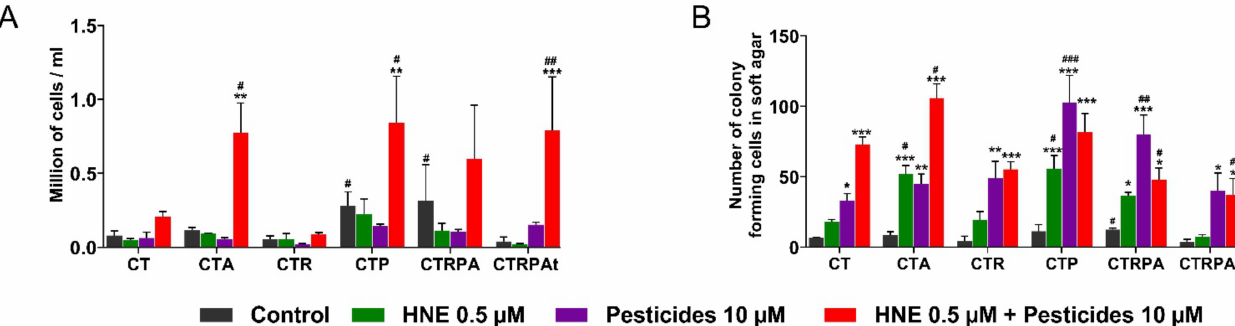
Figure 2. Cell growth and clonogenicity after a three week-exposure to contaminants in HCECs. ( A ) Cell counting at the end of exposure. ( B ) After exposure, HCECs were cultured in soft agar and colonies were quantified after 10 days. Results in ( A , B ) panels represent the mean ± SEM of three independent experiments; statistical differences were analysed by post-hoc tests of a 2-way ANOVA model between control and treated cells (* p < 0.05, ** p < 0.01, *** p < 0.001) or between CT cells and others isogenic HCECs (# p < 0.05, ## p < 0.01, ### p <